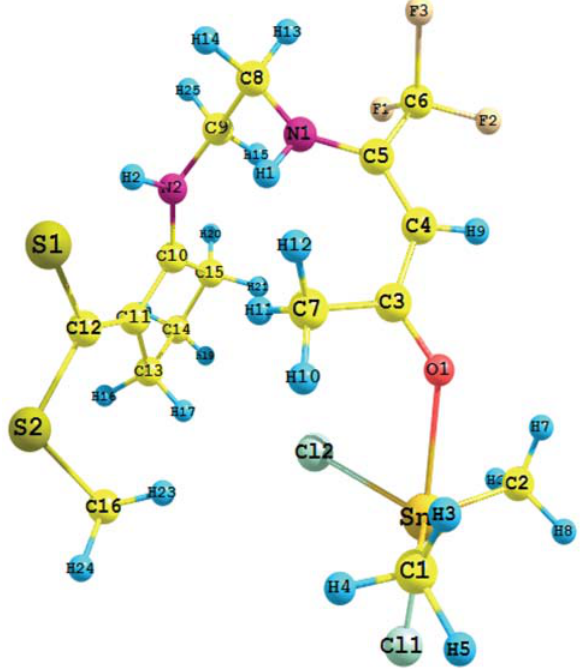
Figure 3. The optimized structures of the [ SnMe